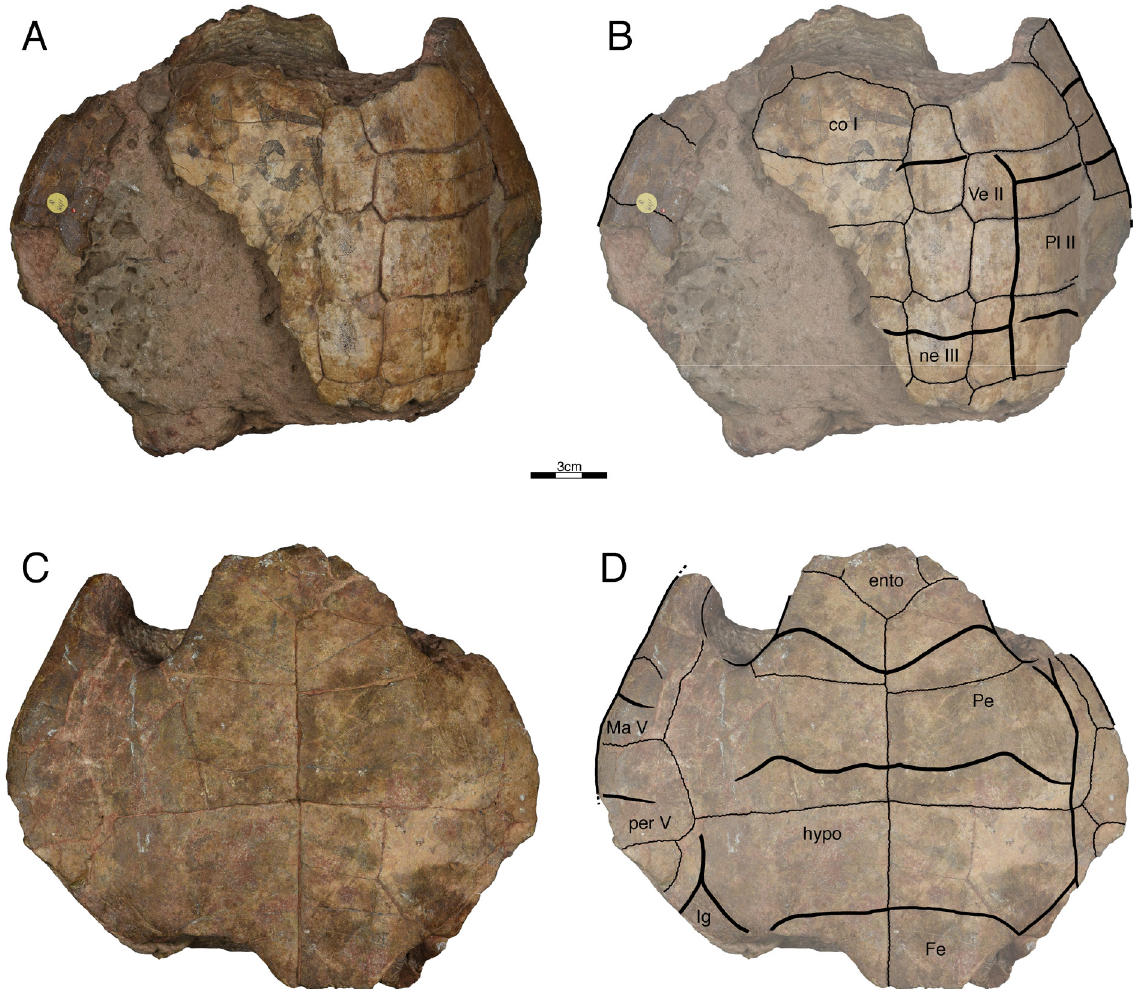
Fig. 13. BMNH R.891, referred to Cachuga lineata (Gray, 1831) by Lydekker (1889b), here identified as Batagur kachuga (Gray, 1831). A . Photograph of carapace. B . Illustration of carapace. C . Photograph of plastron. D . Illustration of plastron. Scale bar: